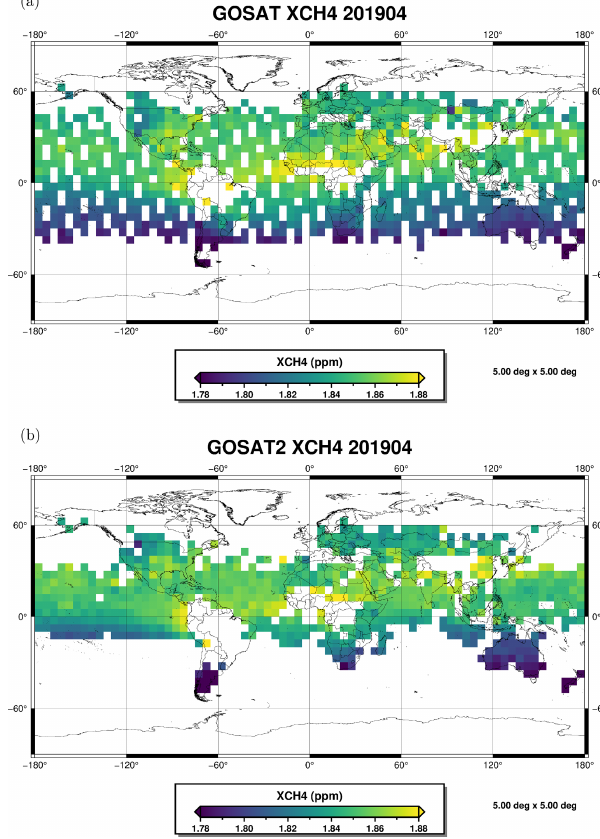
Figure 4. Maps of gridded XCH 4 data for April 2019: (a) GOSAT; (b)